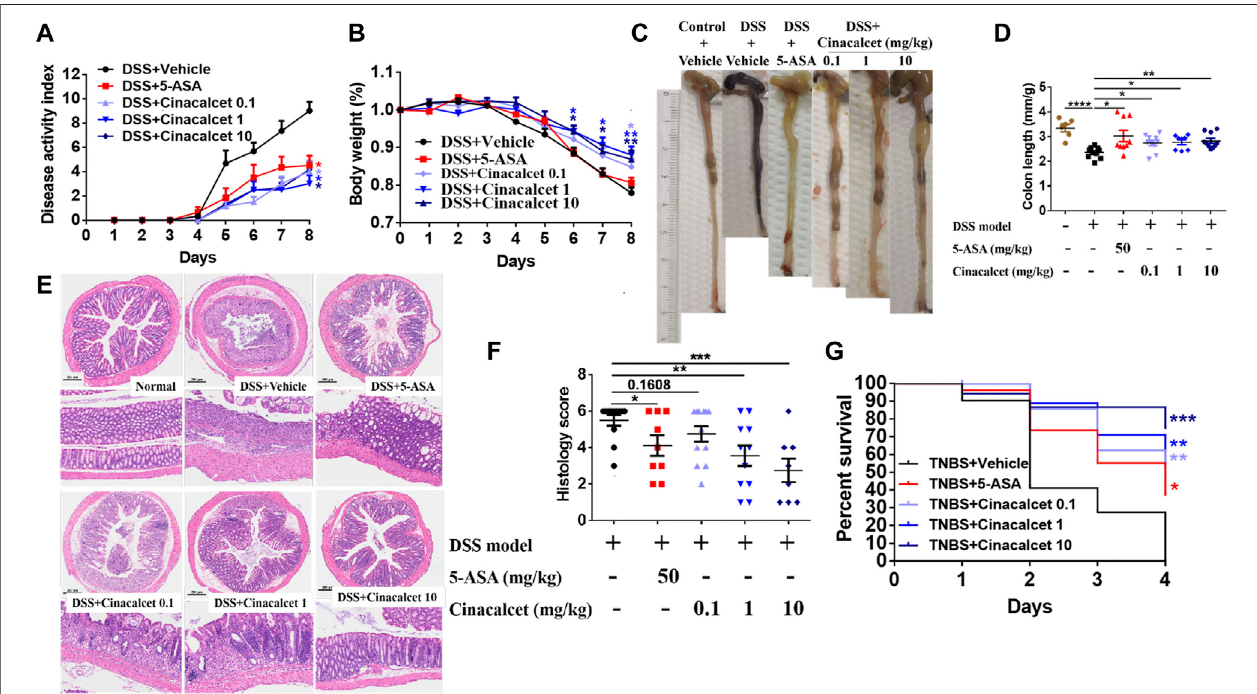
FIGURE 2 | Cinacalcet shows therapeutic effects against dextran sulfate sodium (DSS)-induced colitis. A DSS-induced colitis model, based on 8-week-old wild- type C57BL/6 mice, was established via free access to drinking water containing 3% DSS for 5 days followed by normal drinking water for 3 days, with 10 mice in each group. Drug dilution buffer for the vehicle group, 5-ASA (positive control, 50 mg/kg), and cinacalcet (0.1, 1, 10 mg/kg) were orally delivered daily 3 days before administering 3% DSS drinking water until the mice were sacri fi ced. (A) Disease activity index score. (B) Body weight. (C) Representative colon fi gures in each group. (D) Statistic colon lengths of each group. (E) H&E staining (200 μ m). (F) Quanti fi cation of histology score of H&E staining. (G) Percent survival in TNBS-induced colitis model ( n (cid:2) 10). * p < 0.05, ** p < 0.01, *** p < 0.001, **** p <